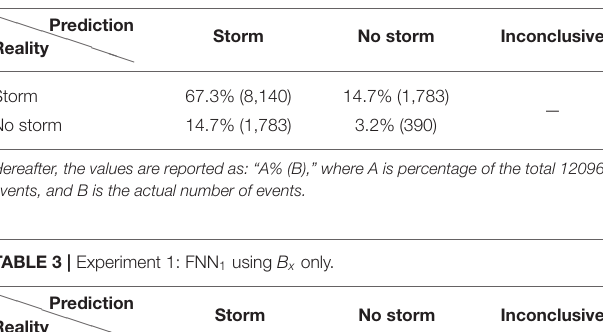
TABLE 2 | No FNN, random guess (weighted by storm:no storm ratio).